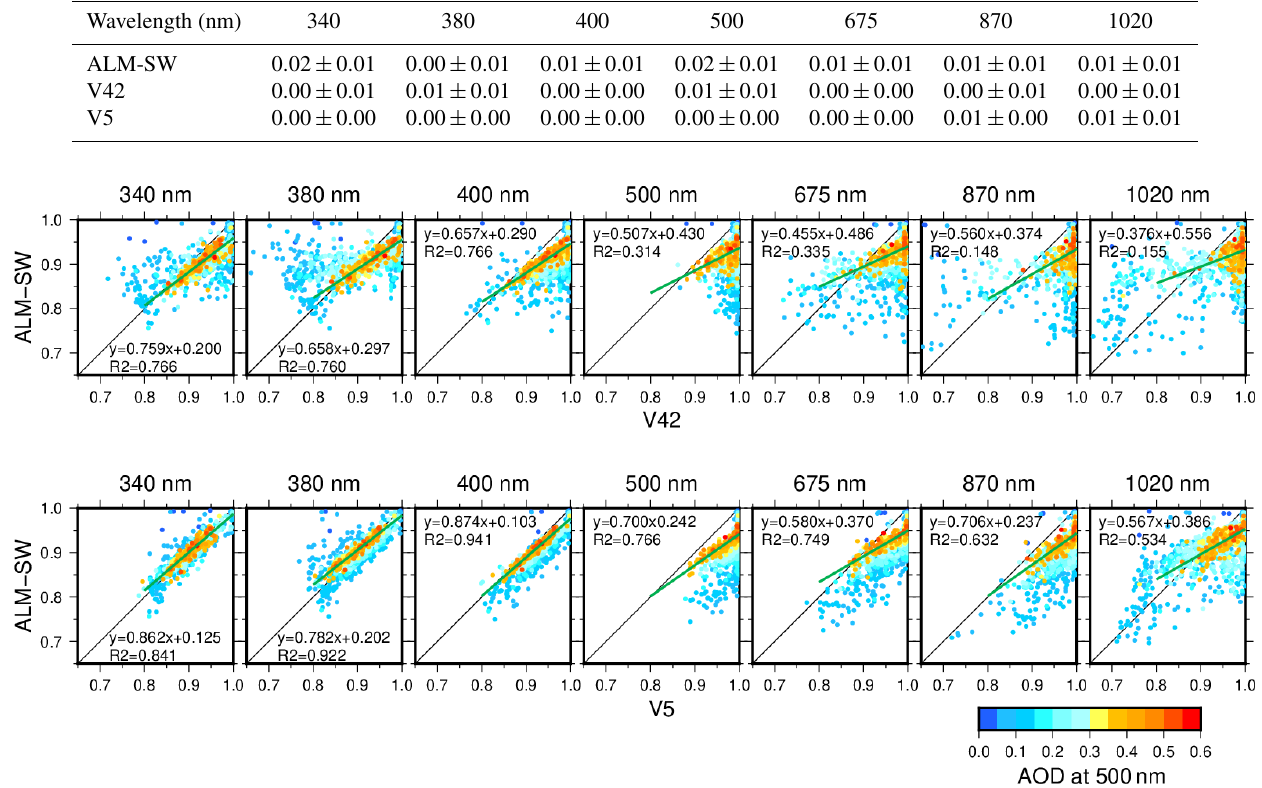
Figure 10. Comparisons of the single-scattering albedo between ALM-SW, V42, and V5. Colors indicate the aerosol optical depth at 500nm; y = ax + b and R2 are the linear fitting and the coefficient of determination for the data relating to an aerosol optical depth of more than